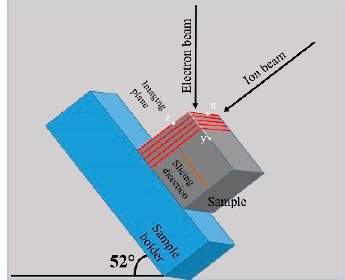
Figure 9. Schematic illustration of the sample, ion beam and electron beam for serial sectioning in the FIB-SEM, in order to perform 3D tomographic reconstruction.